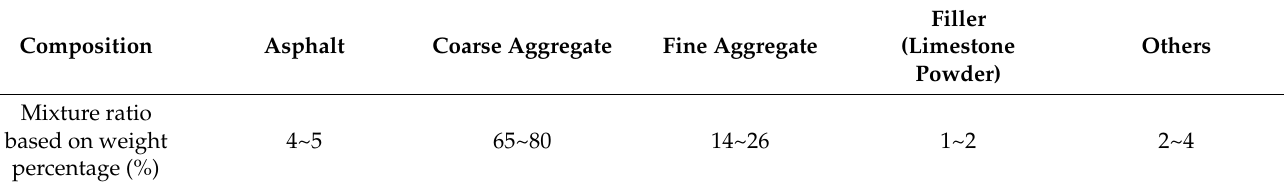
Table 3. APC pavement material composition.